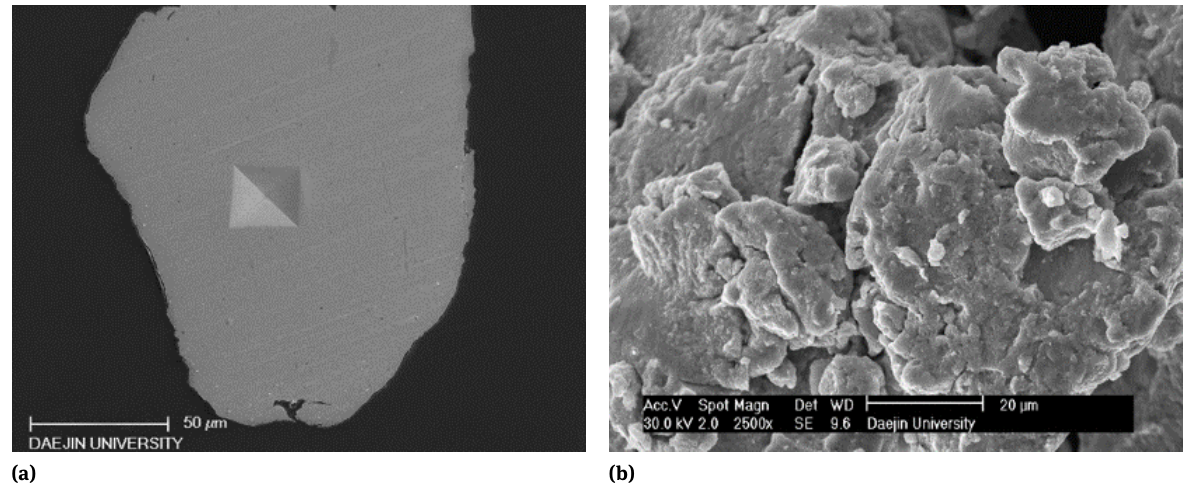
Figure 4: (a) SEM micrograph (left) of cross section of the as-milled Cu-4Cr 2 O 3 powder, showing the indentation of Vickers hardness test (b) A typical SEM picture(right), showing the morphology of the powers.